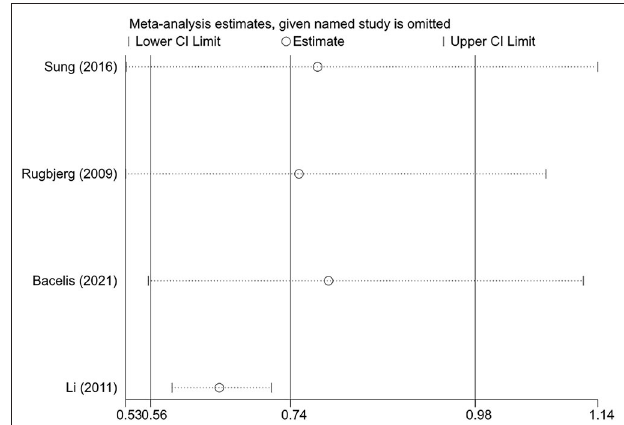
FIGURE 3 | The effects of the individual studies on the pooled effect size of Parkinson’s disease risk.